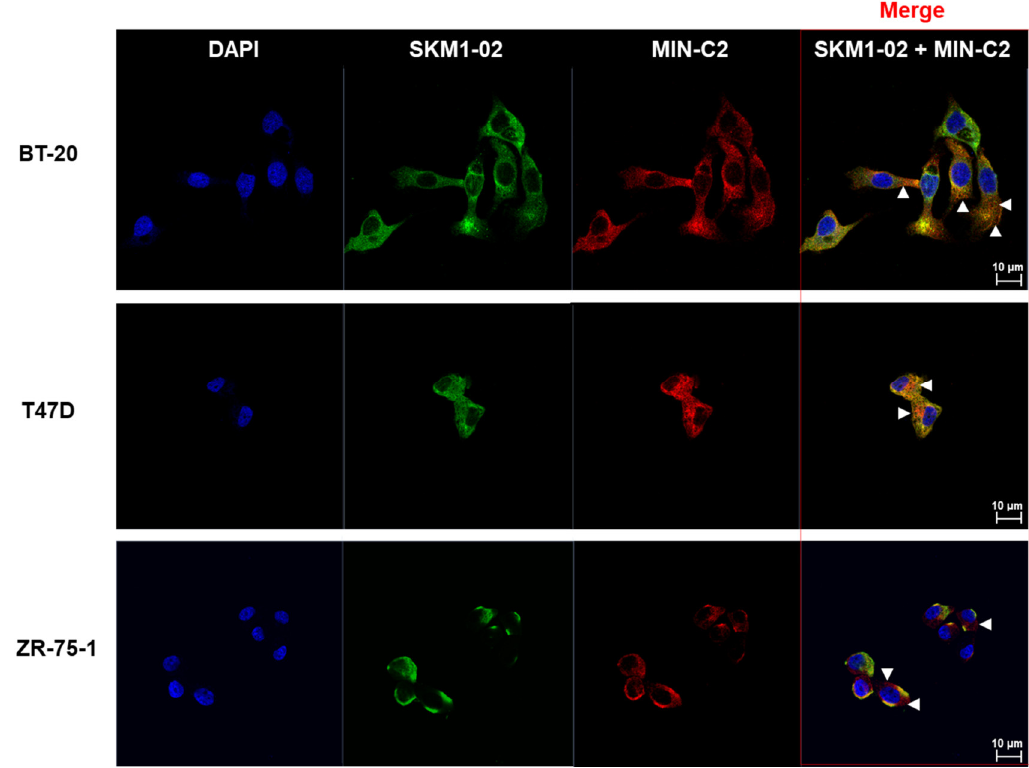
Figure 5. BT-20, T47D, and ZR75-1 cells were surface-stained with SKM1-02 Ab and/or MIN-C2 (mouse IgG2a version) Ab . The samples were stained using anti-human IgG Ab conjugated with Alexa 488 and anti-mouse IgG Ab conjugated with Alexa 647 secondary antibodies, respectively. Images were visualized by confocal microscopy (CLSM system; LSM 700, Carl Zeiss, Jena, Germany). Scale bar, 10 µm. FACS analysis was performed by SKM1-02 and/or MIN-C2 (MUC1-C*) with a mouse IgG constant region.